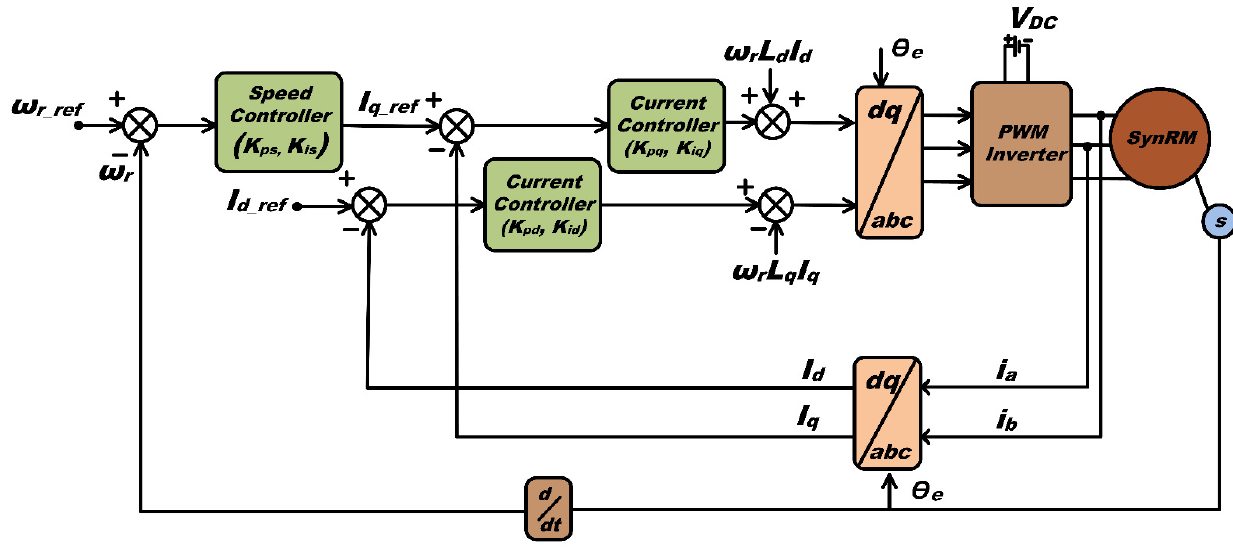
Figure 1. Speed control of the SynRM in the FOC frame.